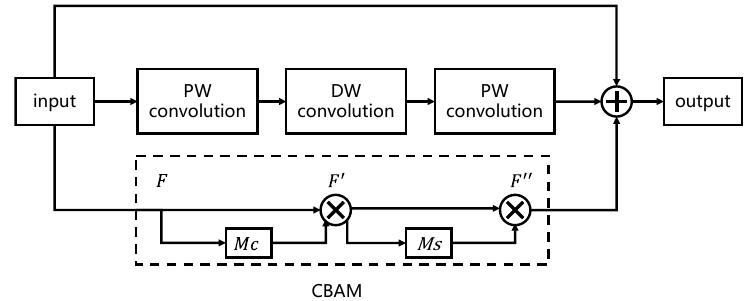
Figure 7. Bottleneck structure embedded in CBAM module.